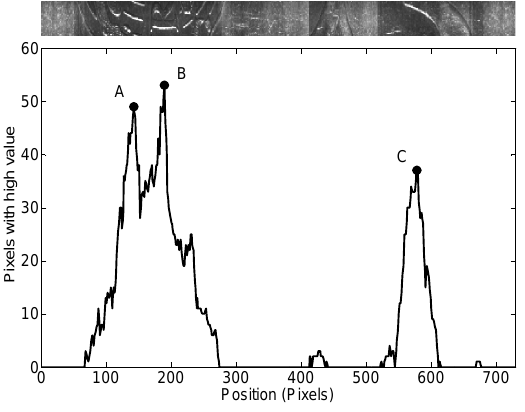
Figure 11. Number of white pixels found in the images of the common side of the two- Euro coin. The angular displacement was measured with a second optical sensor in the other side.